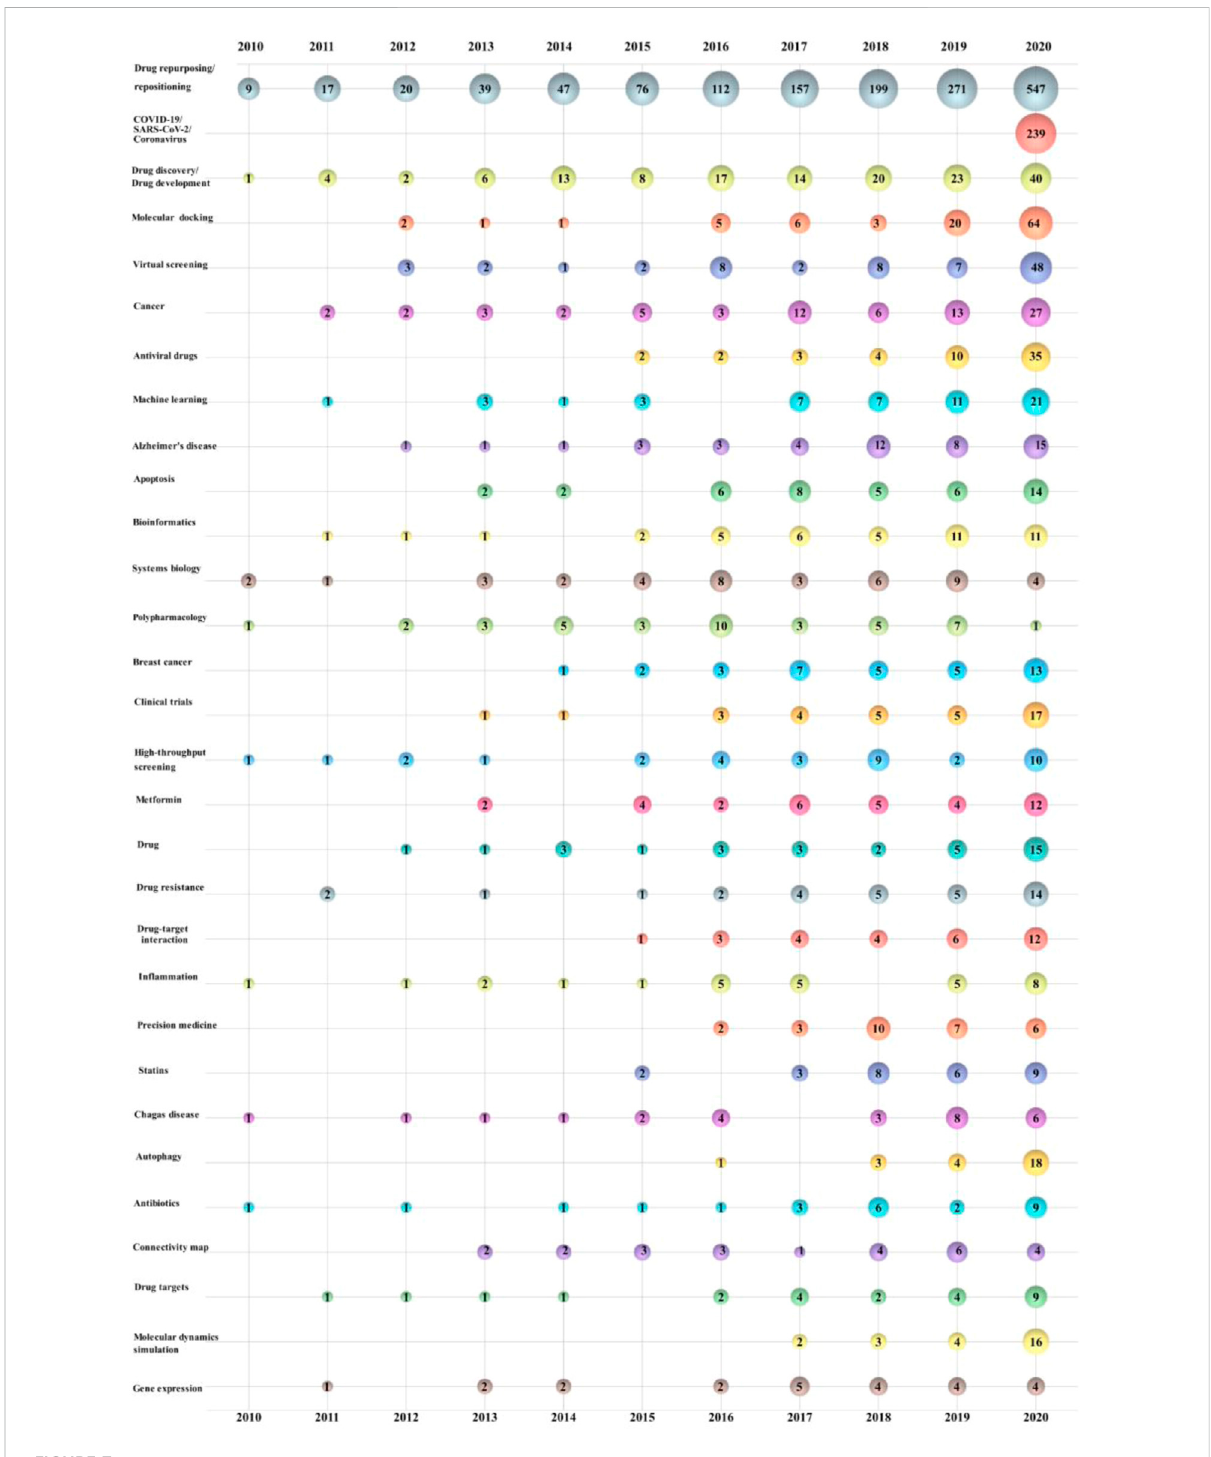
FIGURE 7 Bubble chart of the top 30 author keywords by